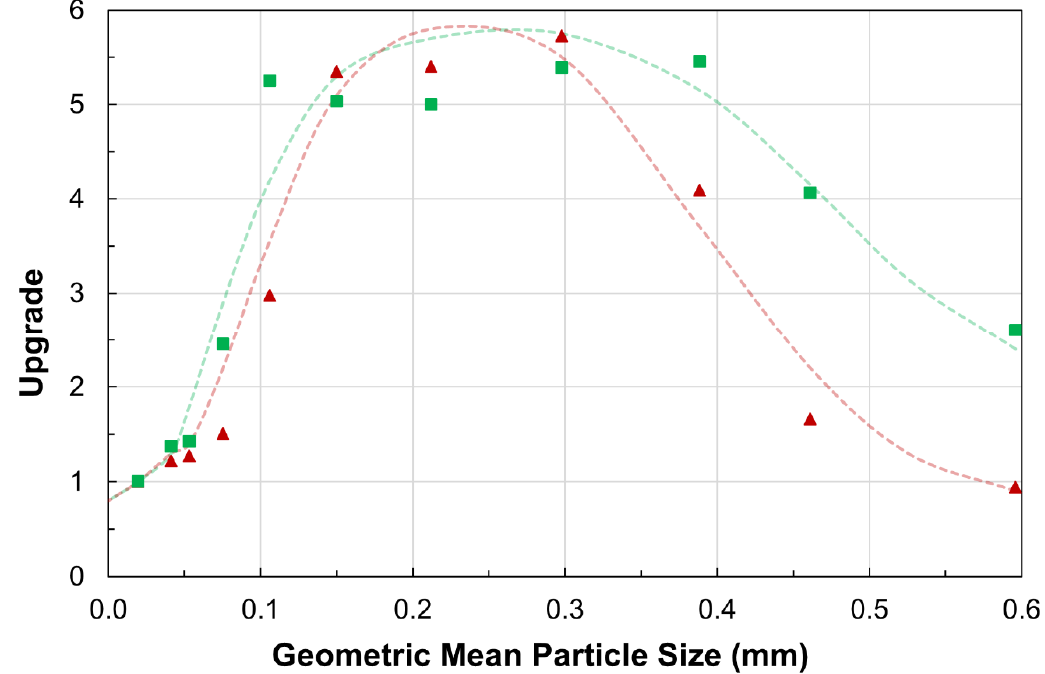
Figure 10. Upgrade, defined as the ratio of product grade to feed grade, as a function of geometric mean particle size for best (green squares) and poorer (red triangles) performing runs. The impact of entrained gangue on the grade of product is shown, where the higher gas flux had a lower asso- ciated grade for almost all size